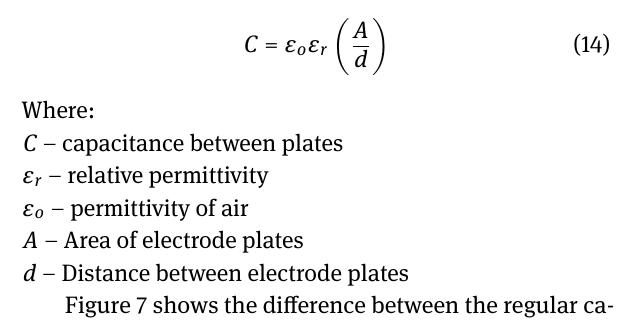
Figure 5: Fabrication process flow sequence for